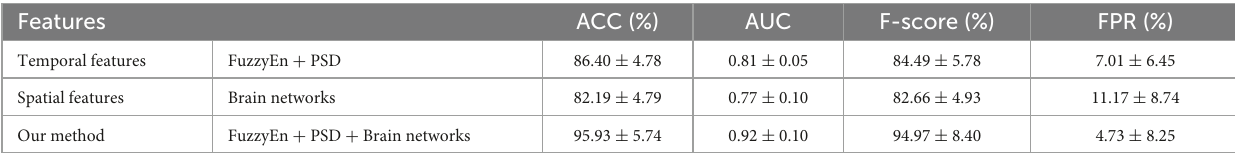
TABLE 7 Comparing the proposed spatiotemporal features method for seizure prediction with only temporal or spatial features on the CHB-MIT dataset.